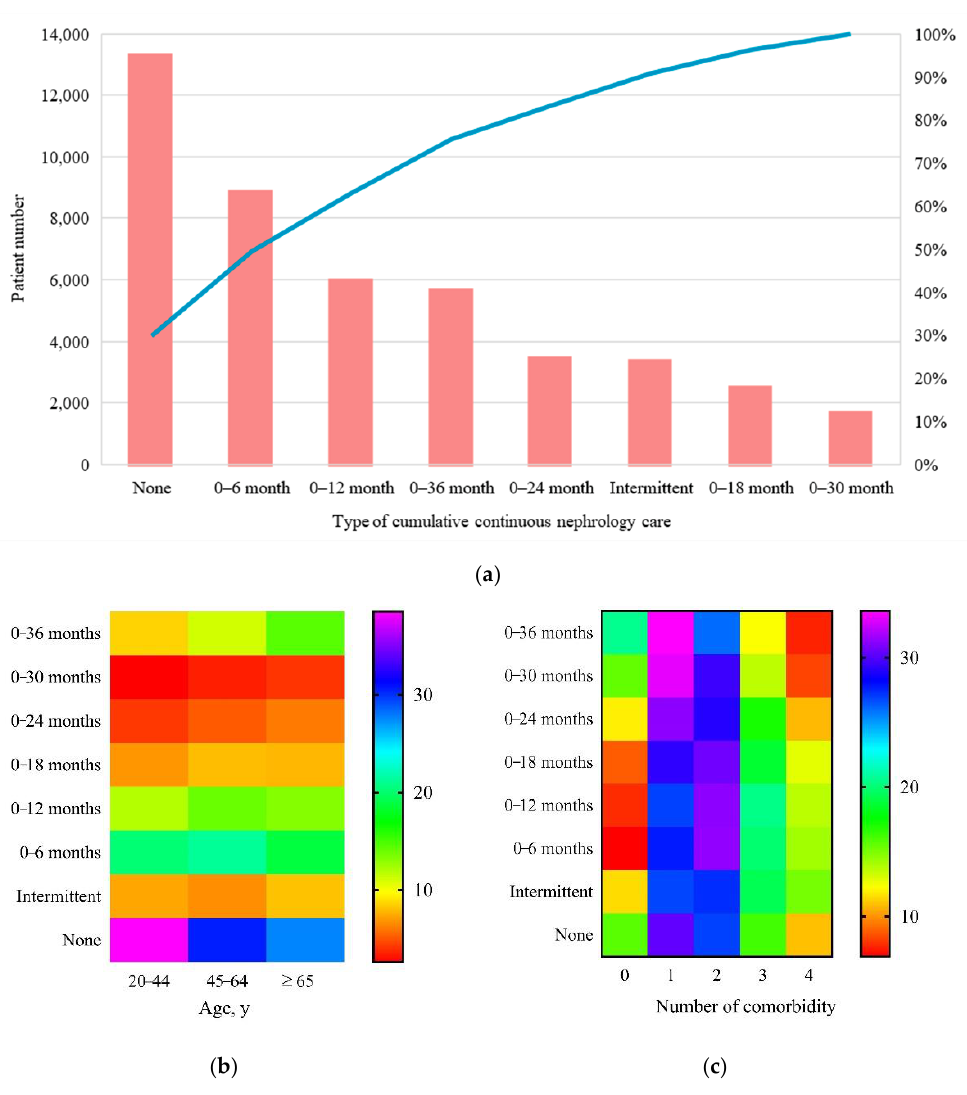
Figure 2. Distribution in nephrology care. ( a ) Patient number in different types of nephrology care and their cumulative percentage; ( b ) Heat map comparing proportions of types of cumulative nephrology care between age groups (20 – 44, 45 –64, and ≥ 65 years); ( c ) Heat map comparing proportions of types of cumulative nephrology care in patients with different comorbidity numbers (0, 1, 2, 3, and ≥4).